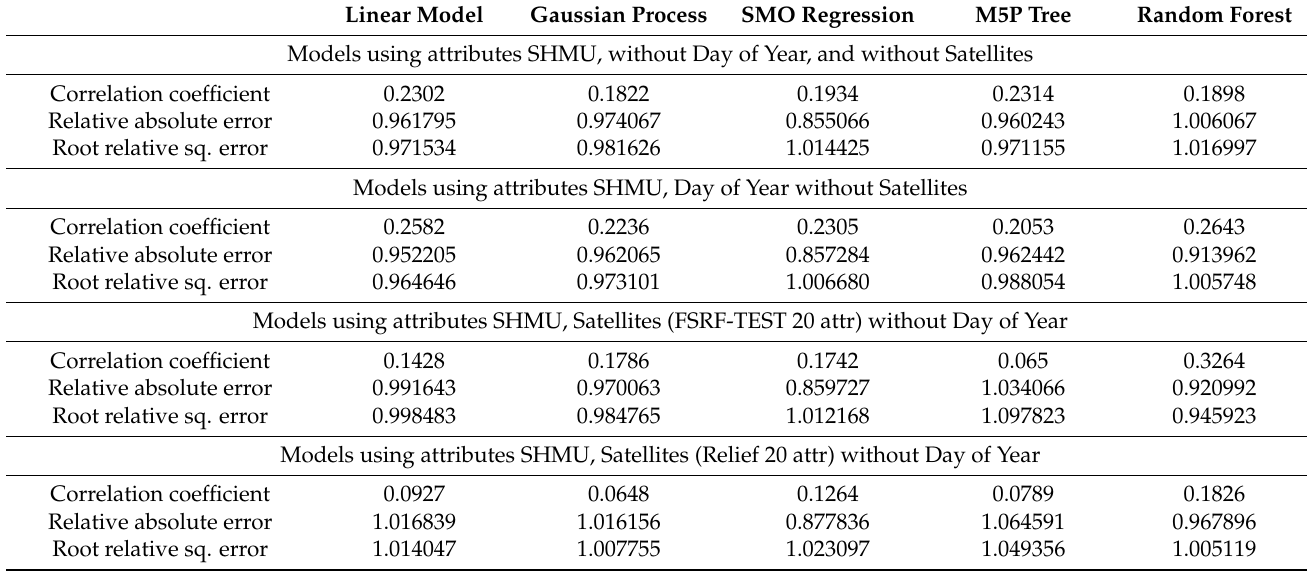
Table 3. Overview of trained regression models and their accuracy metrics for the field-measured values of target variable Sr (soluble fraction of